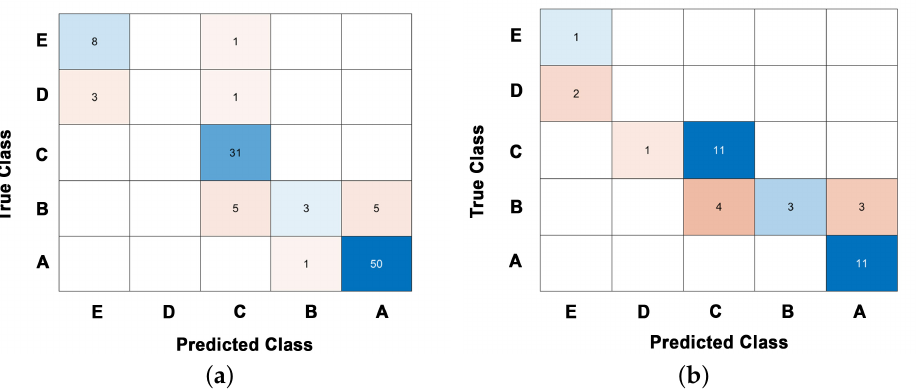
Figure 9. kNN classifier: effect of randomization on the training and testing accuracies. The high- lighted trials are respectively characterized by to the maximum (run 16), minimum (run 21), and av- erage accuracy (run 47).